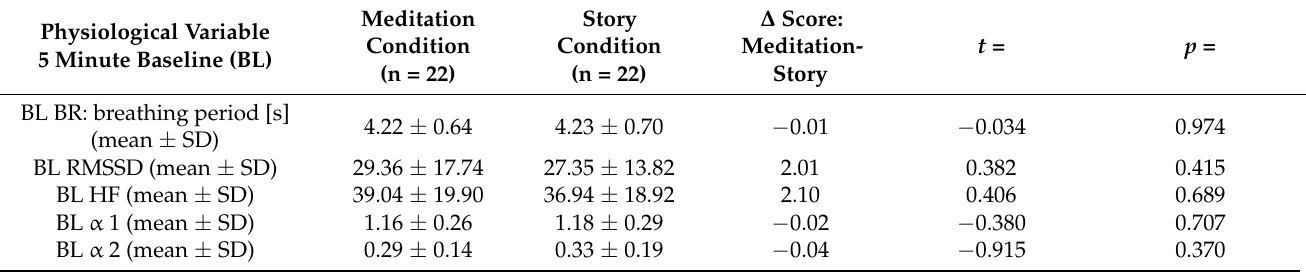
Table 2. Descriptive statistics for the physiological variables for the 5 min baseline (BL) measured before the meditation and story condition, respectively, and for the two 20 minute meditation and story sessions. A difference score ( ∆ ) indicates the value differences between the meditation and the story condition. Significant t -test coefficients for the differences between the two